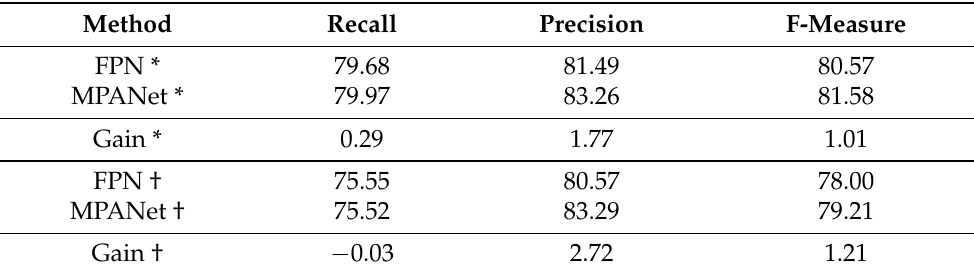
Table 2. The performance gain of MPANet. * and † are results from ICDAR2015 and CTW1500, respectively. FPN * and FPN † represent the results of using the FPN network model in PSE [21] on ICDAR2015 and CTW1500,